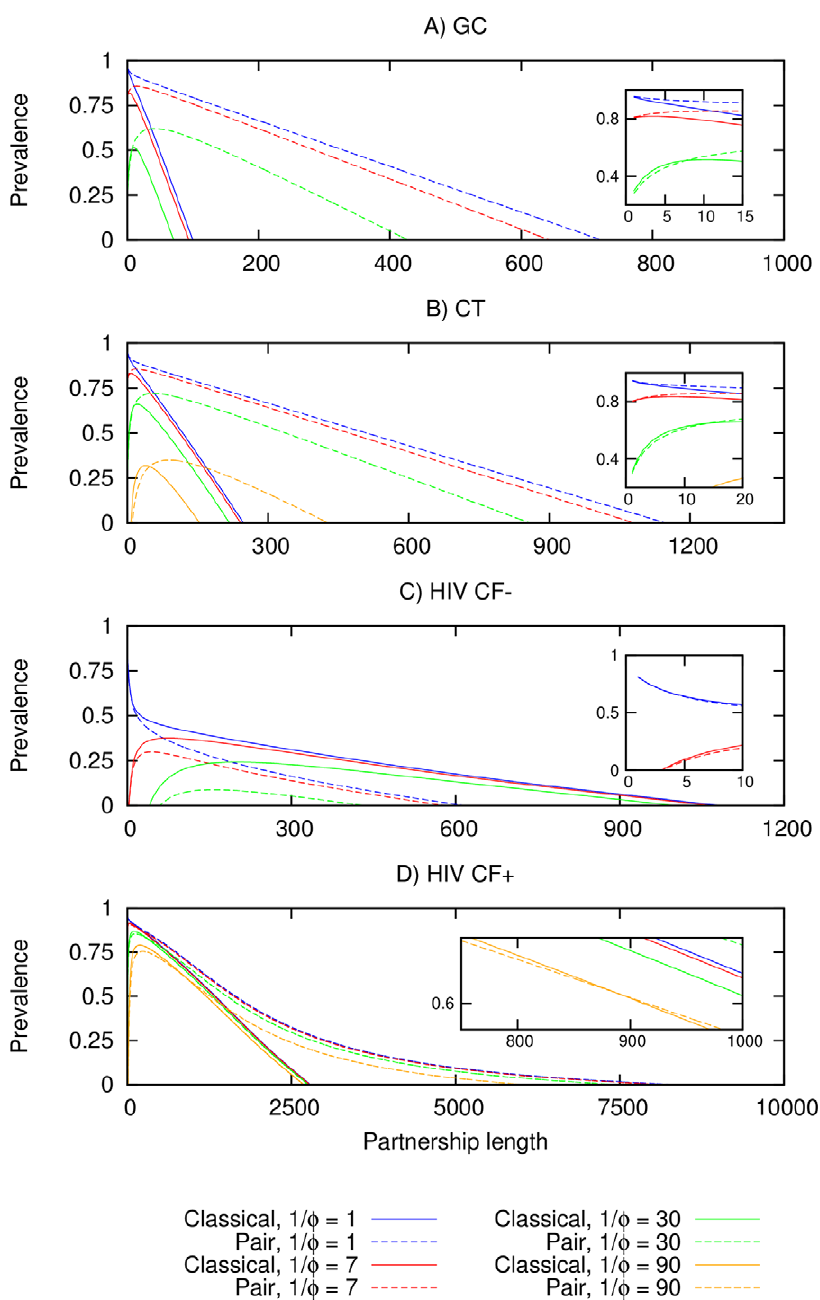
Figure 1. Predictions from the classical and pair model formulations for the steady-state p s of GC/CT (A and B), and the peak p p of HIV with and without cofactor enhancement (C and D). The horizontal axes give partnership length in days while the vertical axes give p . The different lines denote predictions from using gap lengths ( 1 = q ) of 1 day, 7 days, 30 days and 90 days. The inset in each figure magnifies crossover point, if any, in the region where the classical and pair models diverge in p predictions. Models in (A) and (C) are unable to provide predictions at a gap length of 90 days. doi:10.1371/journal.pone.0039575.g001 adjustment factors used in the calibrated classical model are at of partnership and gap combinations. The divergence between the the edge of plausibility, since a approaches 10 for GC, and 7.5 for predictions of the pair and calibrated classical model is elaborated CT at longer partnership lengths, in effect assuming infectious on in Figures 3A and B, which highlight the areas where the periods in the realm of several years. In contrast, after the classical absolute difference in predicted C c values is close to 100% for GC model for HIV was calibrated by adjusting per sex act (i.e. combinations when C c approaches the maximum of 100% in transmission probabilities, predicted C c values are fairly close to the calibrated model and is close to 0% in the pair model). those from the pair model (Figures 2K and 2L); differences are less However, Figures 3E and F show that the corresponding